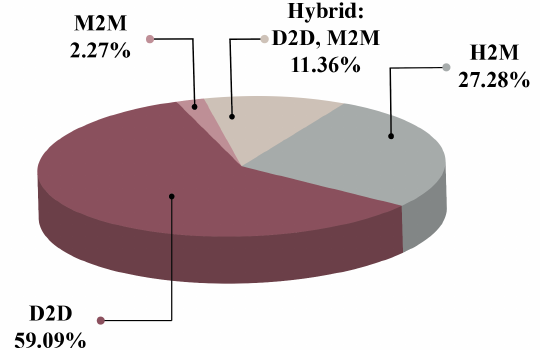
Figure 11. Communication